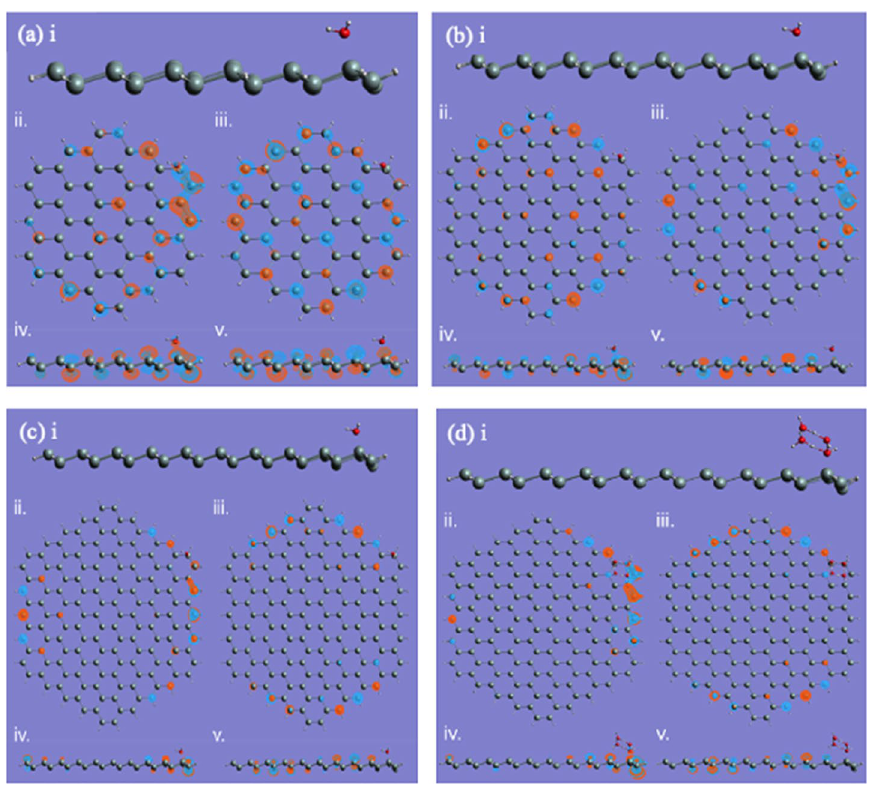
Figure 5. The water-molecule absorptions on the edge of the SND: ( a ) 3 × 3 ; ( b ) 4 × 4; ( c ) 5 × 5 . The ice square on 5 × 5 is shown in ( d ). The optimized structures are shown in (i) for each scenario, respectively. In each sub-figure, ((ii) and (iii)), and ((iv) and (v)) are the top (side) views of HOMO and LUMO,